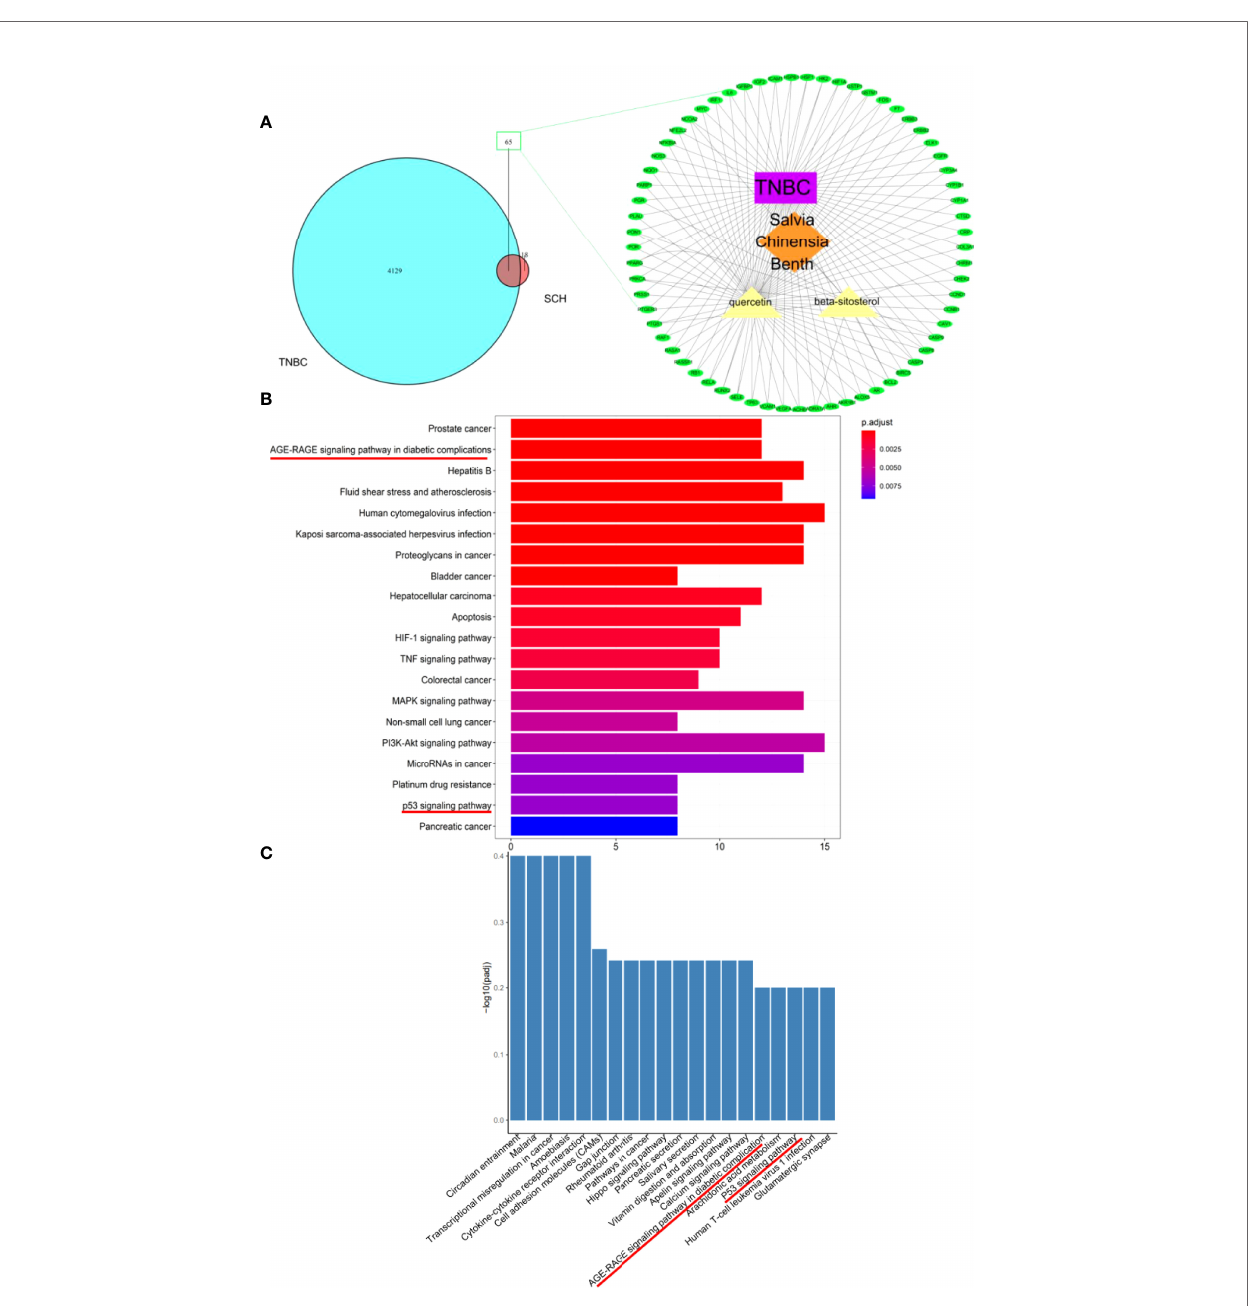
FIGURE 5 | Bioinformatic analysis and transcriptome analysis divulge latent targets of SCH. (A) C – T network of SCH. The green ellipse represents target genes. The purple rectangle, orange diamond, and yellow triangle stand for compounds. KEGG pathway enrichment scrutiny of target genes of SCH from online database (B) and transcriptome analysis (C) . Pathways with attuned P -value <0.05 are